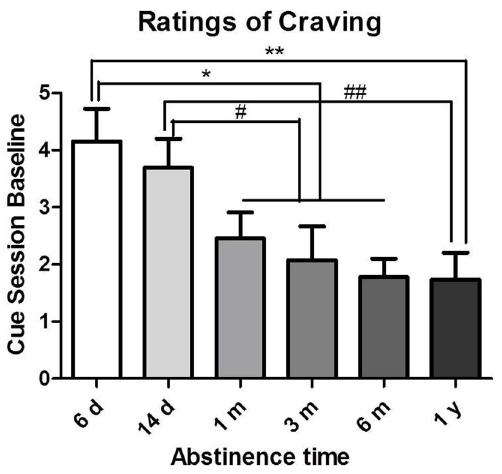
Figure 4. Effects of length of abstinence on baseline (non- provoked) METH craving. * p , 0.05, ** p , 0.01, compared with 6 d group; # p , 0.05, ## p , 0.01, compared with 14 d group. The data are expressed as group means ( 6 SEM).